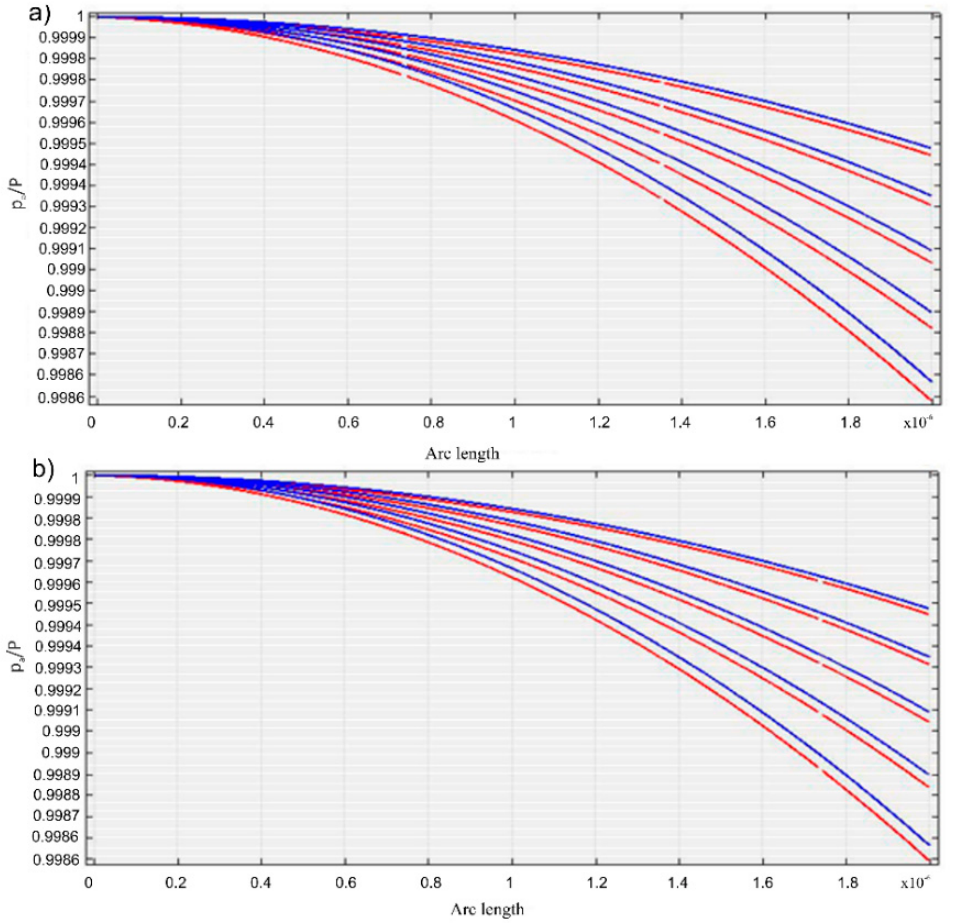
Figure 8. Acoustic pressure in the biphasic environment for HAp (red) for five frequencies and in water (blue) ( a ); Acoustic pressure in the biphasic environment for 7ZnHAp (red) for five frequencies and in water (blue) ( b ).